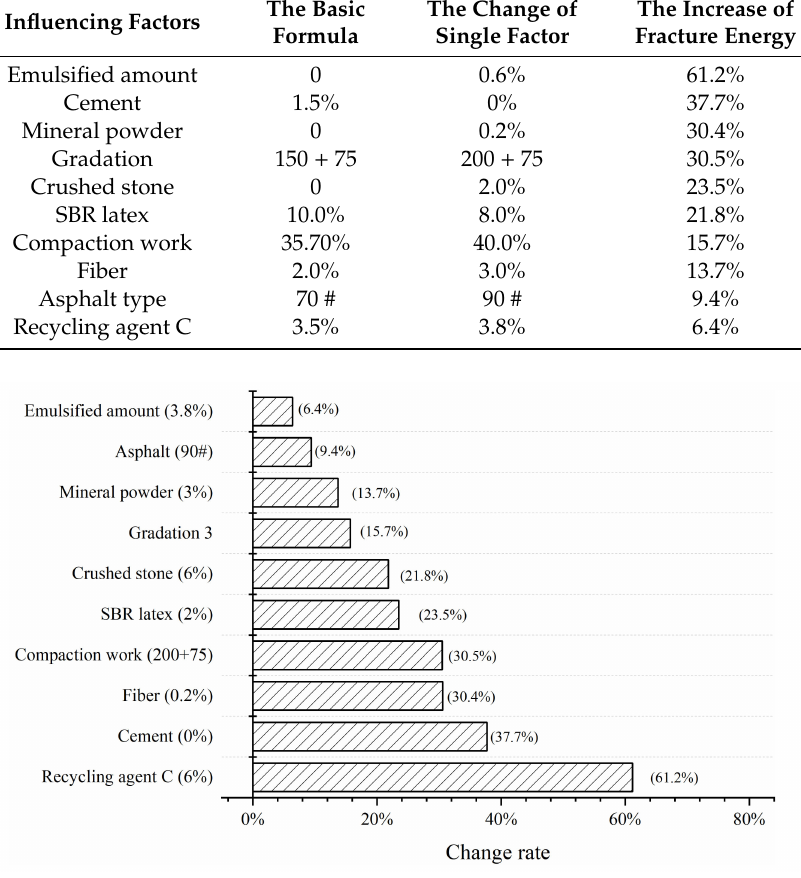
Figure 16. The sorting diagram of influencing factors of fracture